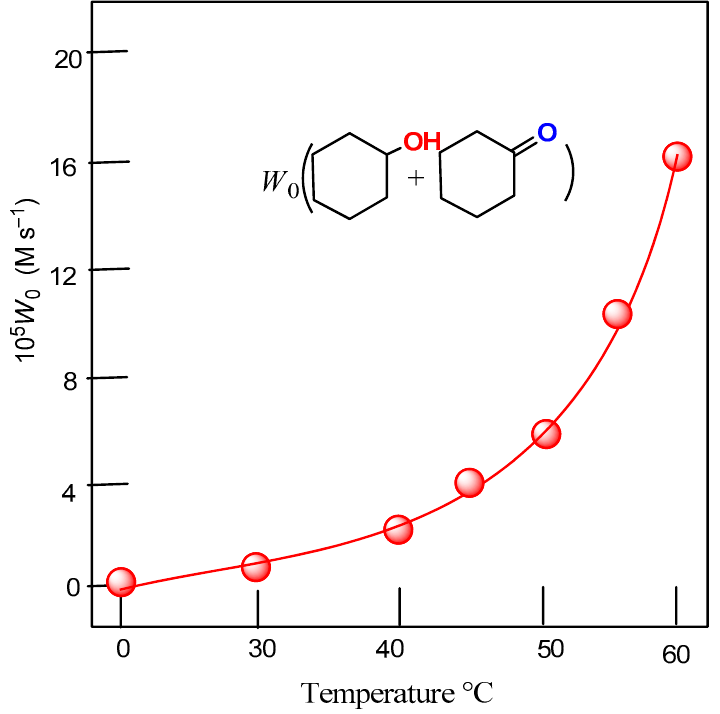
Figure 9. Dependence of the initial rate of oxygenate formation W 0 on temperature of reaction (conditions of reaction: cyclohexane (0.46 M), complex- 2 (5 × 10 − 4 M)/H 2 O 2 (2.0 M)/PCA (2 × 10 − 3 M) in acetonitrile).